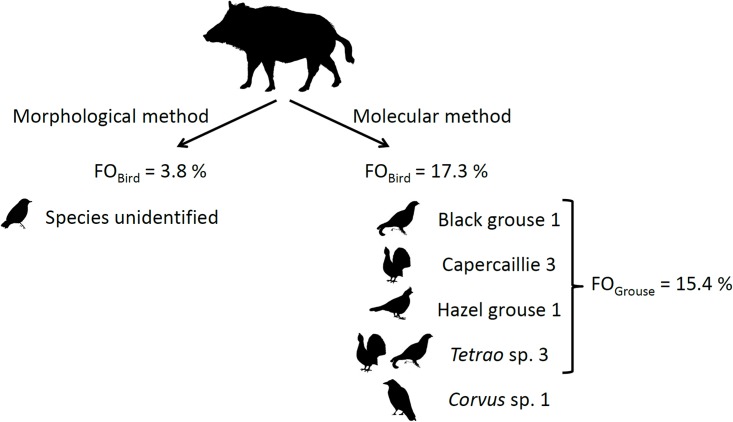
Bird consumption by wild boar in Estonia: Molecular method 4.5× more sensitive than the morphological.FOBird−frequency of occurrence of bird in wild boar diet; FOGrouse−frequency of occurrence of grouse in wild boar diet.